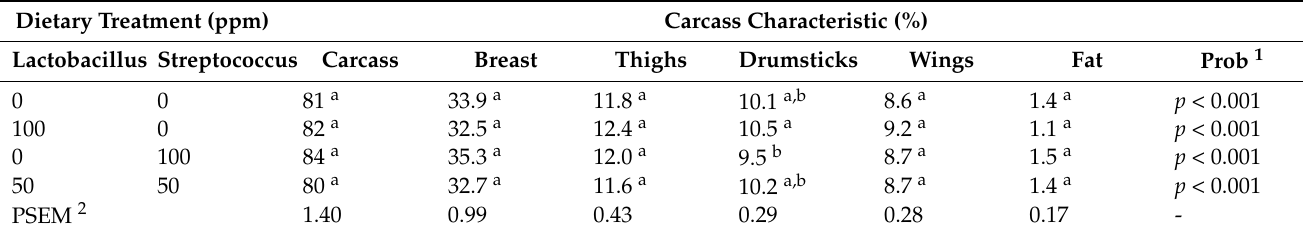
Table 5. Carcass characteristics of chickens fed different probiotics from hatch to 8 WOA. Dietary Treatment (ppm) Carcass Characteristic